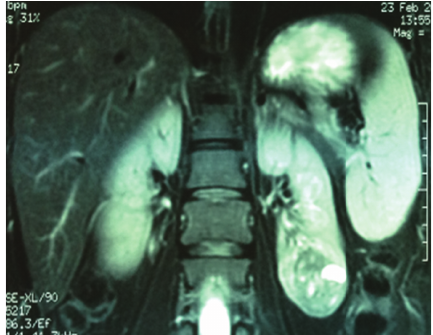
Figure 3: Coronal MR image of a 38-year-old female patient with an incidentally diagnosed left renal mass. Tumor was measuring 4.2 cm in its greatest dimension and R.E.N.A.L. score was 9. She underwent clamped RANSS. Eventual histopathologic diagnosis was Fuhrman grade 3, pT1a, and chromophobic RCC.